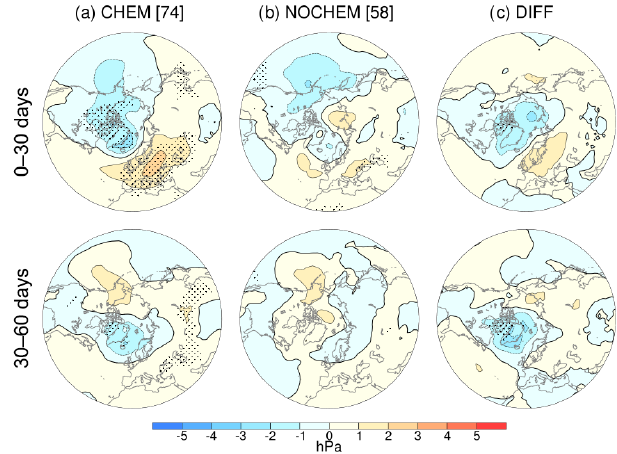
Figure 10. As in Fig. 3 but for DJF SPVs.